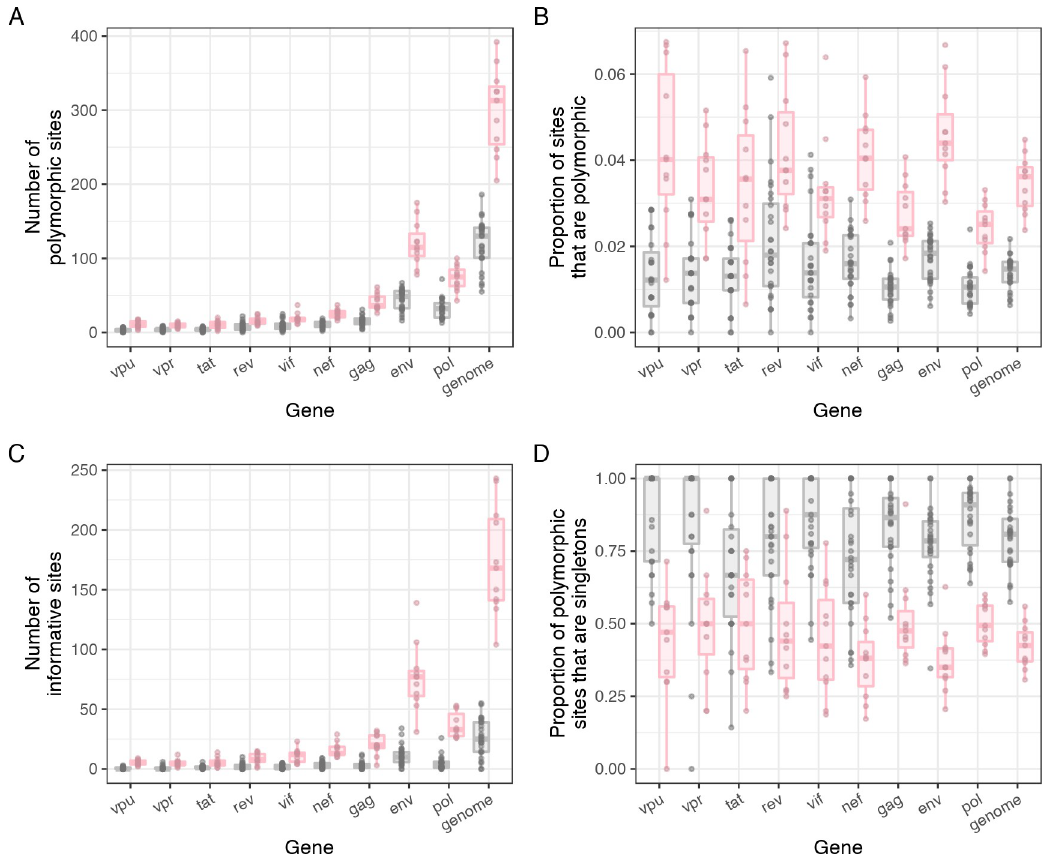
Fig 1. Informative sites identified in the first six months of infection across the 9 HIV-1 genes and genome for 39 participants in the RV217 cohort. A) The number of polymorphic sites. B) The proportion of polymorphic sites. C) The number of informative sites. D) The proportion of polymorphic sites that were only found in one sequence. Genes are ordered by median sequence length across participants. Points are colored gray for participants with infections founded by a single variant, and pink for those founded by multiple